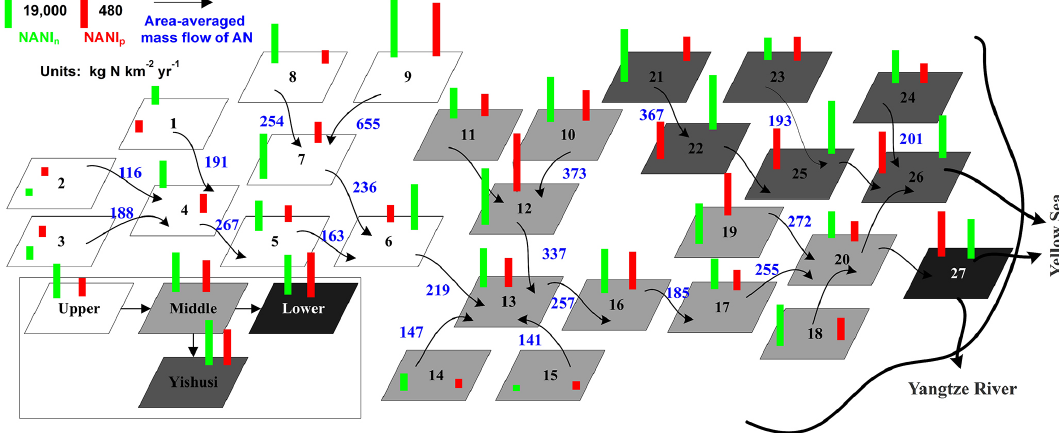
Figure 3. Average net anthropogenic nitrogen inputs and riverine AN flux in the HRB of